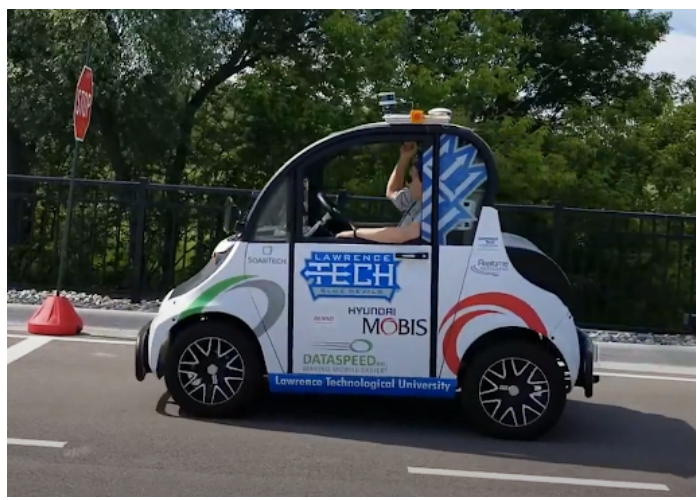
Figure 1. An image of ACTor 1